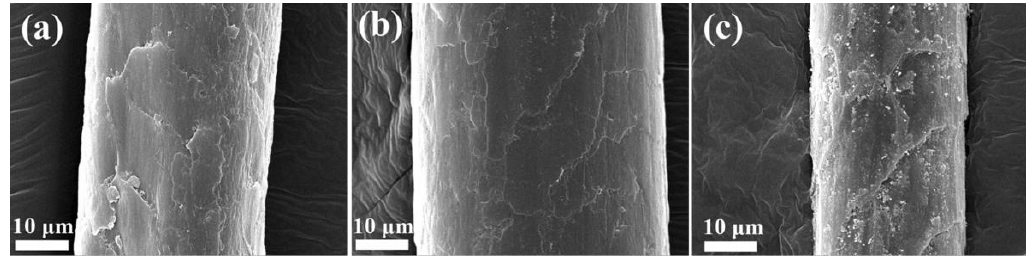
Figure 6. SEM images of camel hair: ( a ) control; ( b ) bleached in the ethanol–water system; ( c ) bleached in the water system.